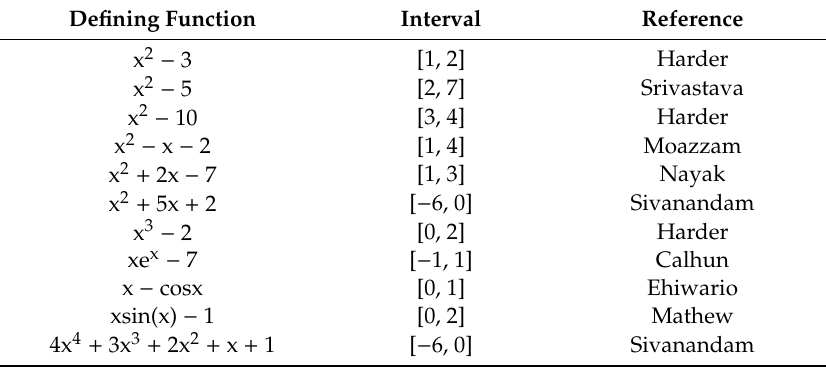
Table 2. From the literature function, domain interval and author of the